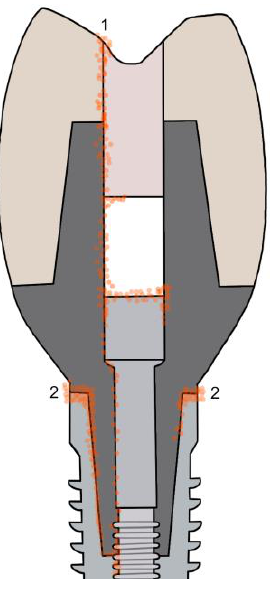
Figure 1. Possible leakage entry and exits of microorganism. (1) Occlusal screw access hole during sealing and/or occlusal function. (2) Implant−abutment junction microgap.